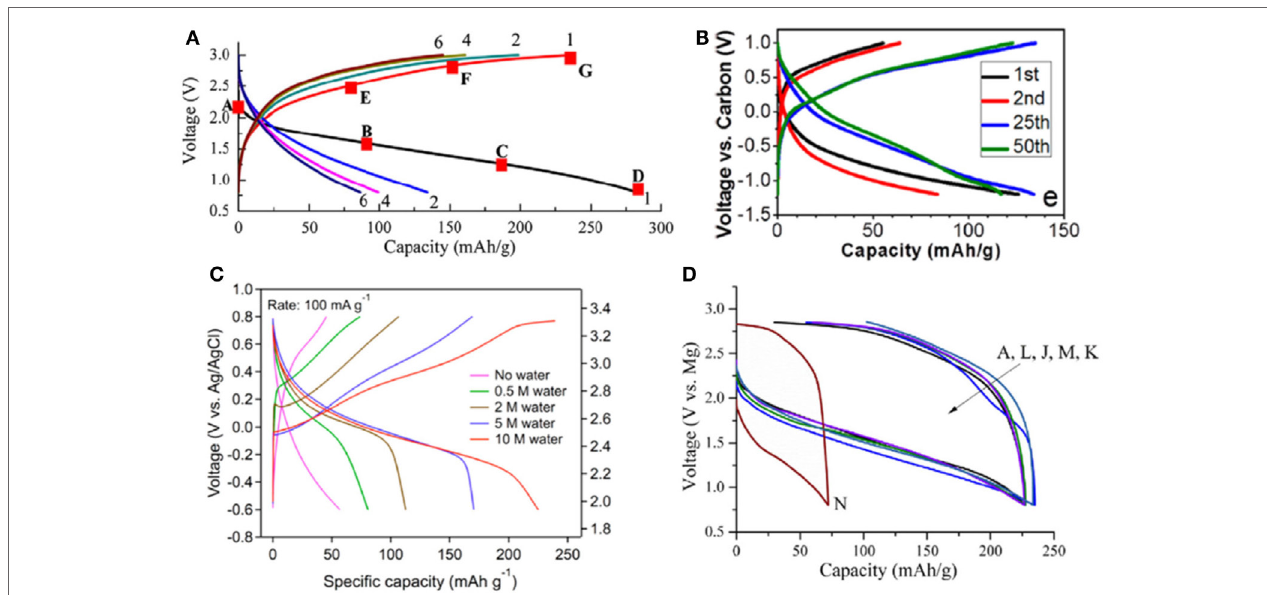
FigURe 1 | Performance of MnO 2 in non-aqueous magnesium battery. (A) α -MnO 2 in 0.2 M Mg-HMDS/tetrahydrofuran. Reprinted with permission from Zhang et al. (2012). Copyright 2012 Elsevier. (B) Birnessite-Mg 0.15 MnO 2 ⋅ 0.9H 2 O in 0.25 M Mg(TFSI) 2 /diglyme. Reprinted with permission from Sun et al. (2016). Copyright 2016 American Chemical Society. (C) Birnessite-MnO 2 ⋅ 0.94H 2 O in 0.5 M Mg(ClO 4 ) 2 /AN with different water concentrations. Reprinted with permission from Nam et al. (2015). Copyright 2016 American Chemical Society. (D) Different polymorphs of MnO 2 in 0.2 M APC/THF. A: α -; L: γ -; J: δ -; M: β -; K: γ ; N: α -mixed with Mn 2 O 3 . Reprinted with permission from Zhang et al. (2015). Copyright 2015